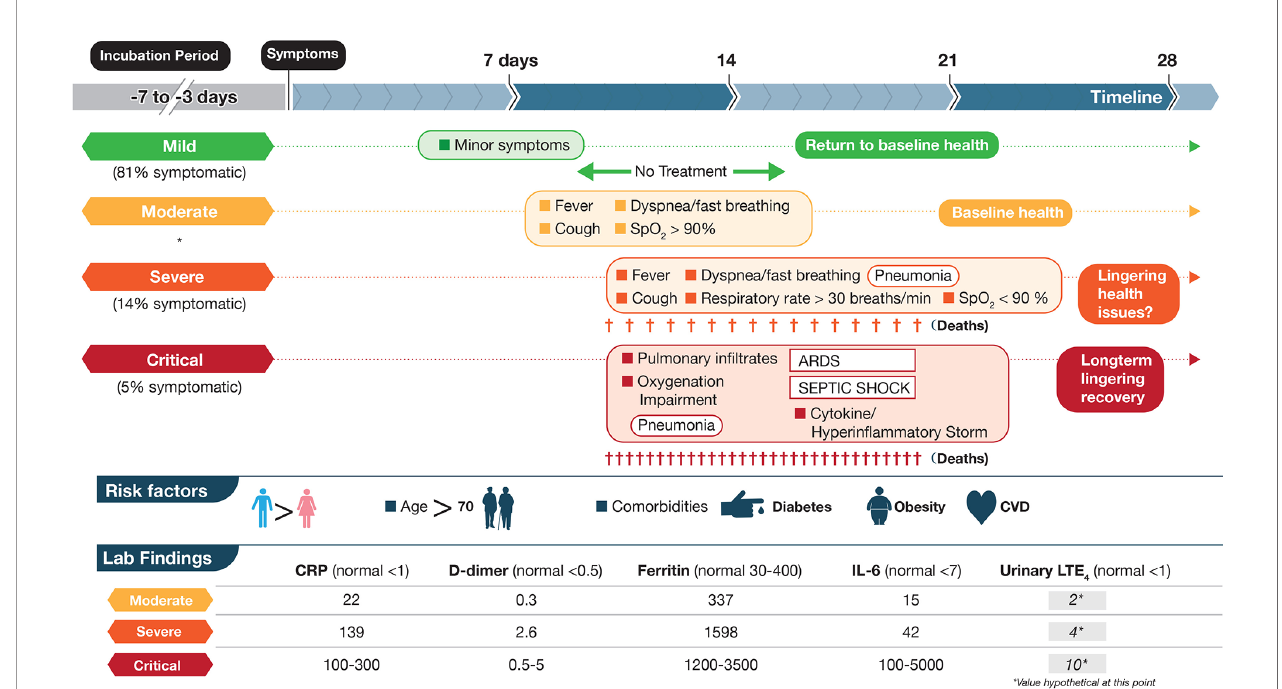
FIGURE 1 | Schematic depictions of mild, moderate, severe, and critical cases of coronavirus disease 2019 (COVID-19) including some symptoms, laboratory fi ndings, and clinical timeline. The disease course is highly variable with dotted lines representing this unpredictability. Criteria are based on World Health Organization categories. In a large cohort of COVID-19 patients that experience symptoms (mentioned in Berlin et al., 2020), percentages are shown in three categories mild, severe and critical. Moderate were not included (shown by *). Up to half of critical cases may die from COVID-19 complications with fewer deaths in the severe category. Lab data are based on (England et al., 2020; table 6) and are meant to show approximations for each marker. Units for CRP, D-dimer, Ferritin, IL-6 are mg/L, m g/ml, m g/L, and pg/ml, respectively. The numbers in the LTE 4 column, at this point, are hypothetical and based on baseline data of urinary LTE 4 levels of ≈ 1 ng/mg creatinine in normal controls and 4 ng/mg creatinine in severe ARDS patients (Bernard et al., 1991). These values would need to be validated in SARS-CoV-2 infected individuals.